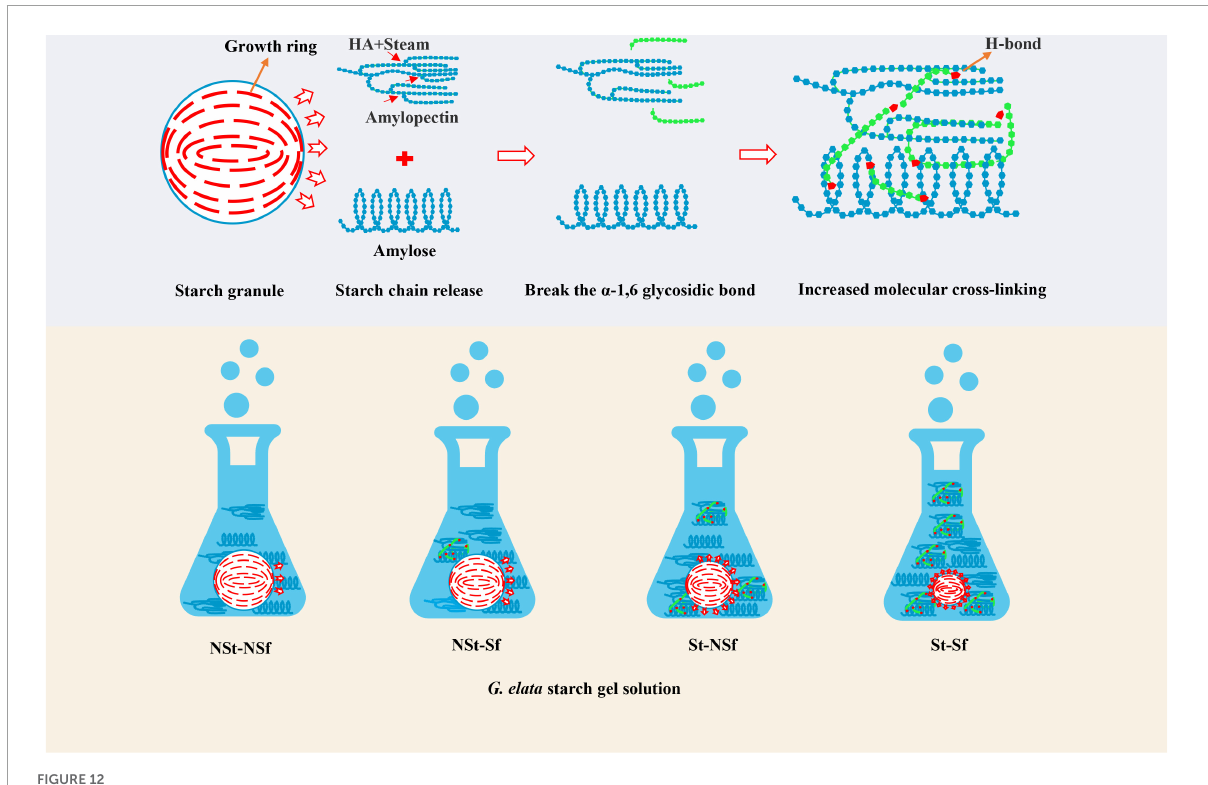
FIGURE12 Schematic diagram of starch cross-linking degree change of Gastrodia elata after steaming and sulfur fumigation